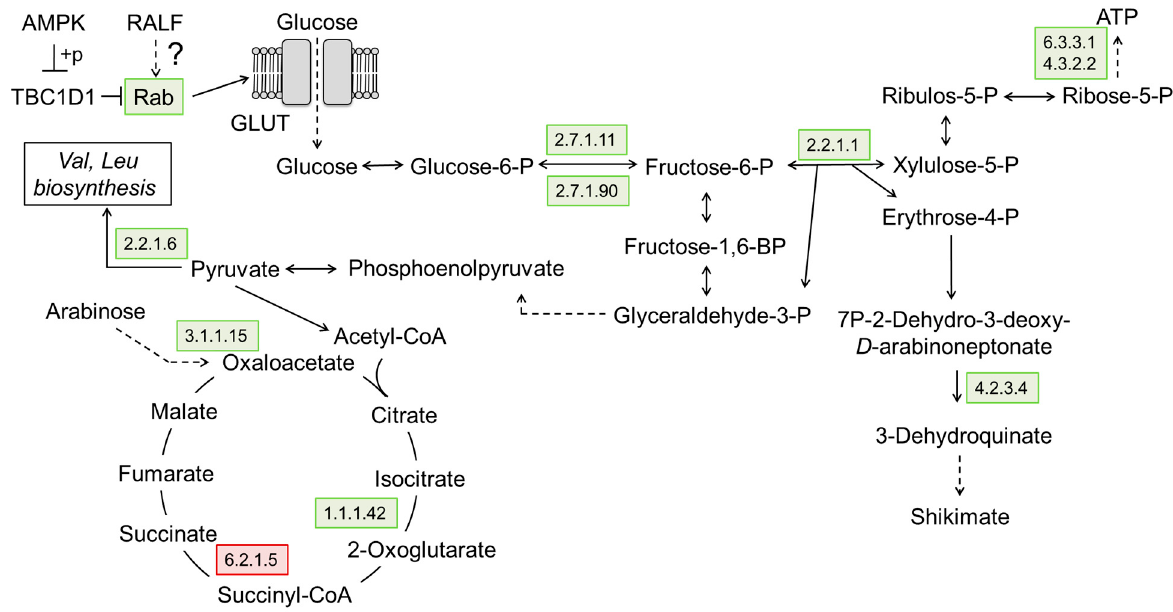
Figure 11. Metabolic pathways affected by the overexpression of CsRALF34 . The up- or downreg- ulated proteins are marked by green and red, respectively. Pathway mapping relied on the KEGG signal pathway database. AMPK, adenosine monophosphate-activated protein kinase; TBC1D1, TBC1 domain family member 1 (TBC1, tre-2/USP6, BUB2, CDC16); Rab, member of the Ras super- family of small G proteins (Rab, Ras-related in brain); ATP, adenosine triphosphate; 5.4.2.8, mannose phosphomutase; 6.3.3.1, phosphoribosyl formylglycinamidine cyclo-ligase; 4.3.2.2, adenylosuccinate lyase; 2.7.1.11, 6-phosphofructokinase; 2.7.1.90, diphosphate-dependent phosphofructokinase; 2.2.1.1, transketolase; 2.2.1.6, acetolactate synthase; 4.2.3.4, 3-dehydroquinate synthase; 1.1.1.42, isocitrate dehydrogenase; 6.2.1.5, succinyl-CoA synthetase. Narrow arrows indicate one step of the pathway; do tt ed arrows indicate several steps.